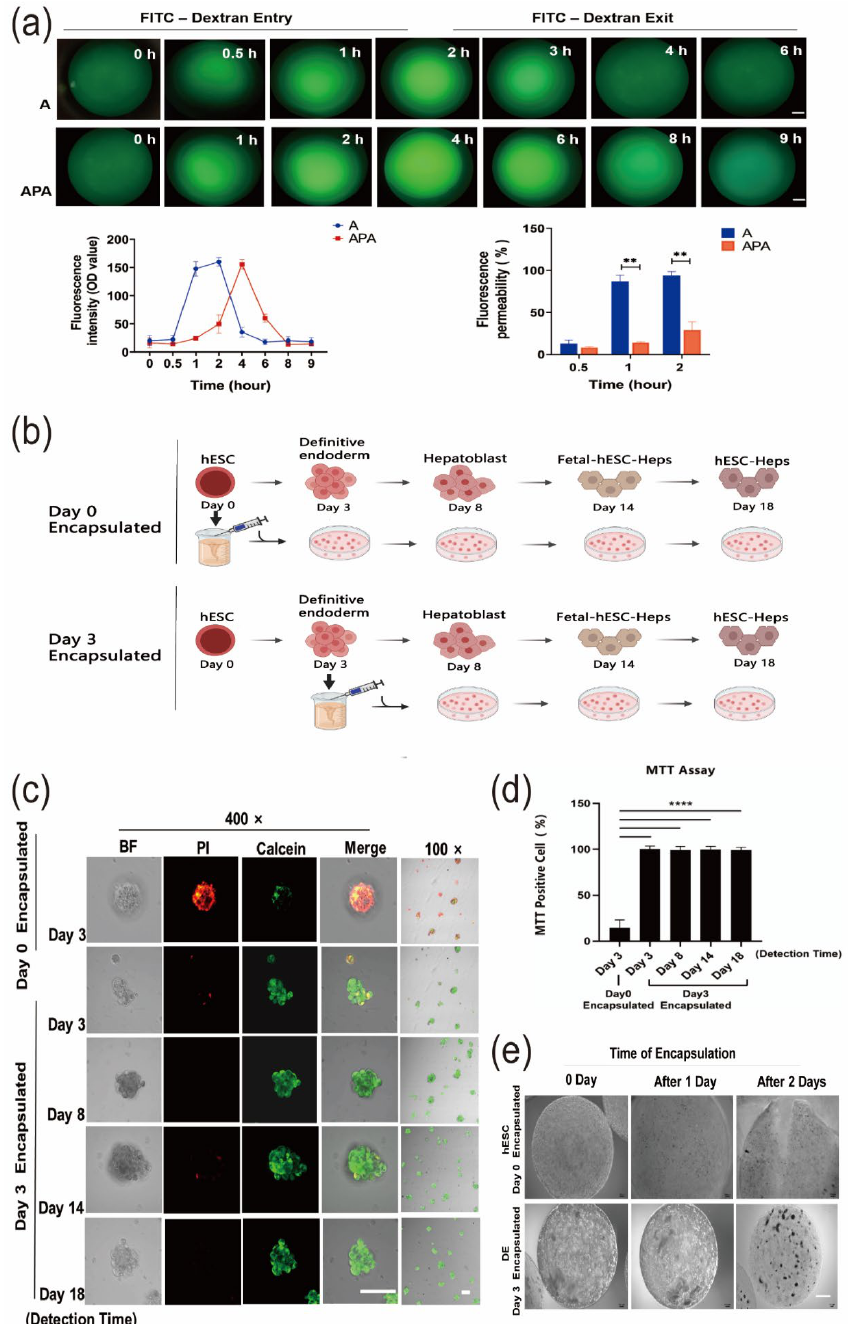
Figure 2. A novel 3D differentiation method using sodium alginate encapsulation. ( a ) Permeabil- ity/of sodium alginate microspheres and sodium alginate–polylysine–sodium alginate microspheres was detected by 60–76 kDa FITC-dextran (scale, 100 µ m). ( b ) Schematic diagram of the 3D cell differentiation procedure. ( c ) Calcein/PI apoptosis staining assay for cell viability on Day 3 after Day 0 encapsulation and during the complete process of differentiation (Day 8, Day 14, and Day 18) after Day 3 encapsulation (scale, 100 µ m). ( d ) MTT assay for detecting cell viability during the complete differentiation process following Day 0 encapsulation and Day 3 encapsulation. ( e ) Microsphere morphology following microsphere encapsulation on Day 0 and Day 3 (scale, 500 µ m). Data are the mean ± SD ( n = 3) and analyzed by Student’s t test. ** p < 0.01, **** p <